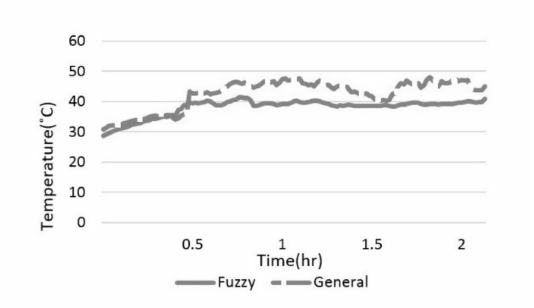
Figure 11. Comparison of the stable differences with or without fuzzy logic